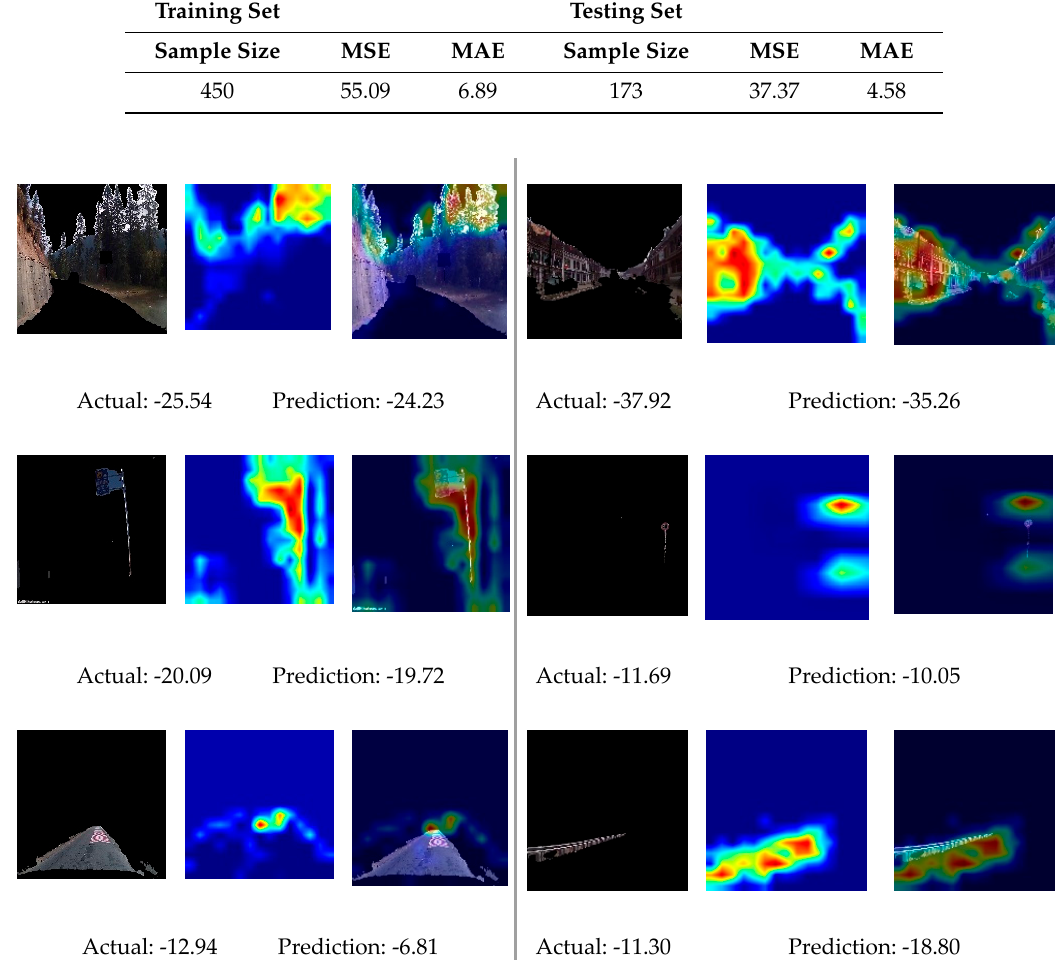
Figure 3. Recognition results from the CNN model.